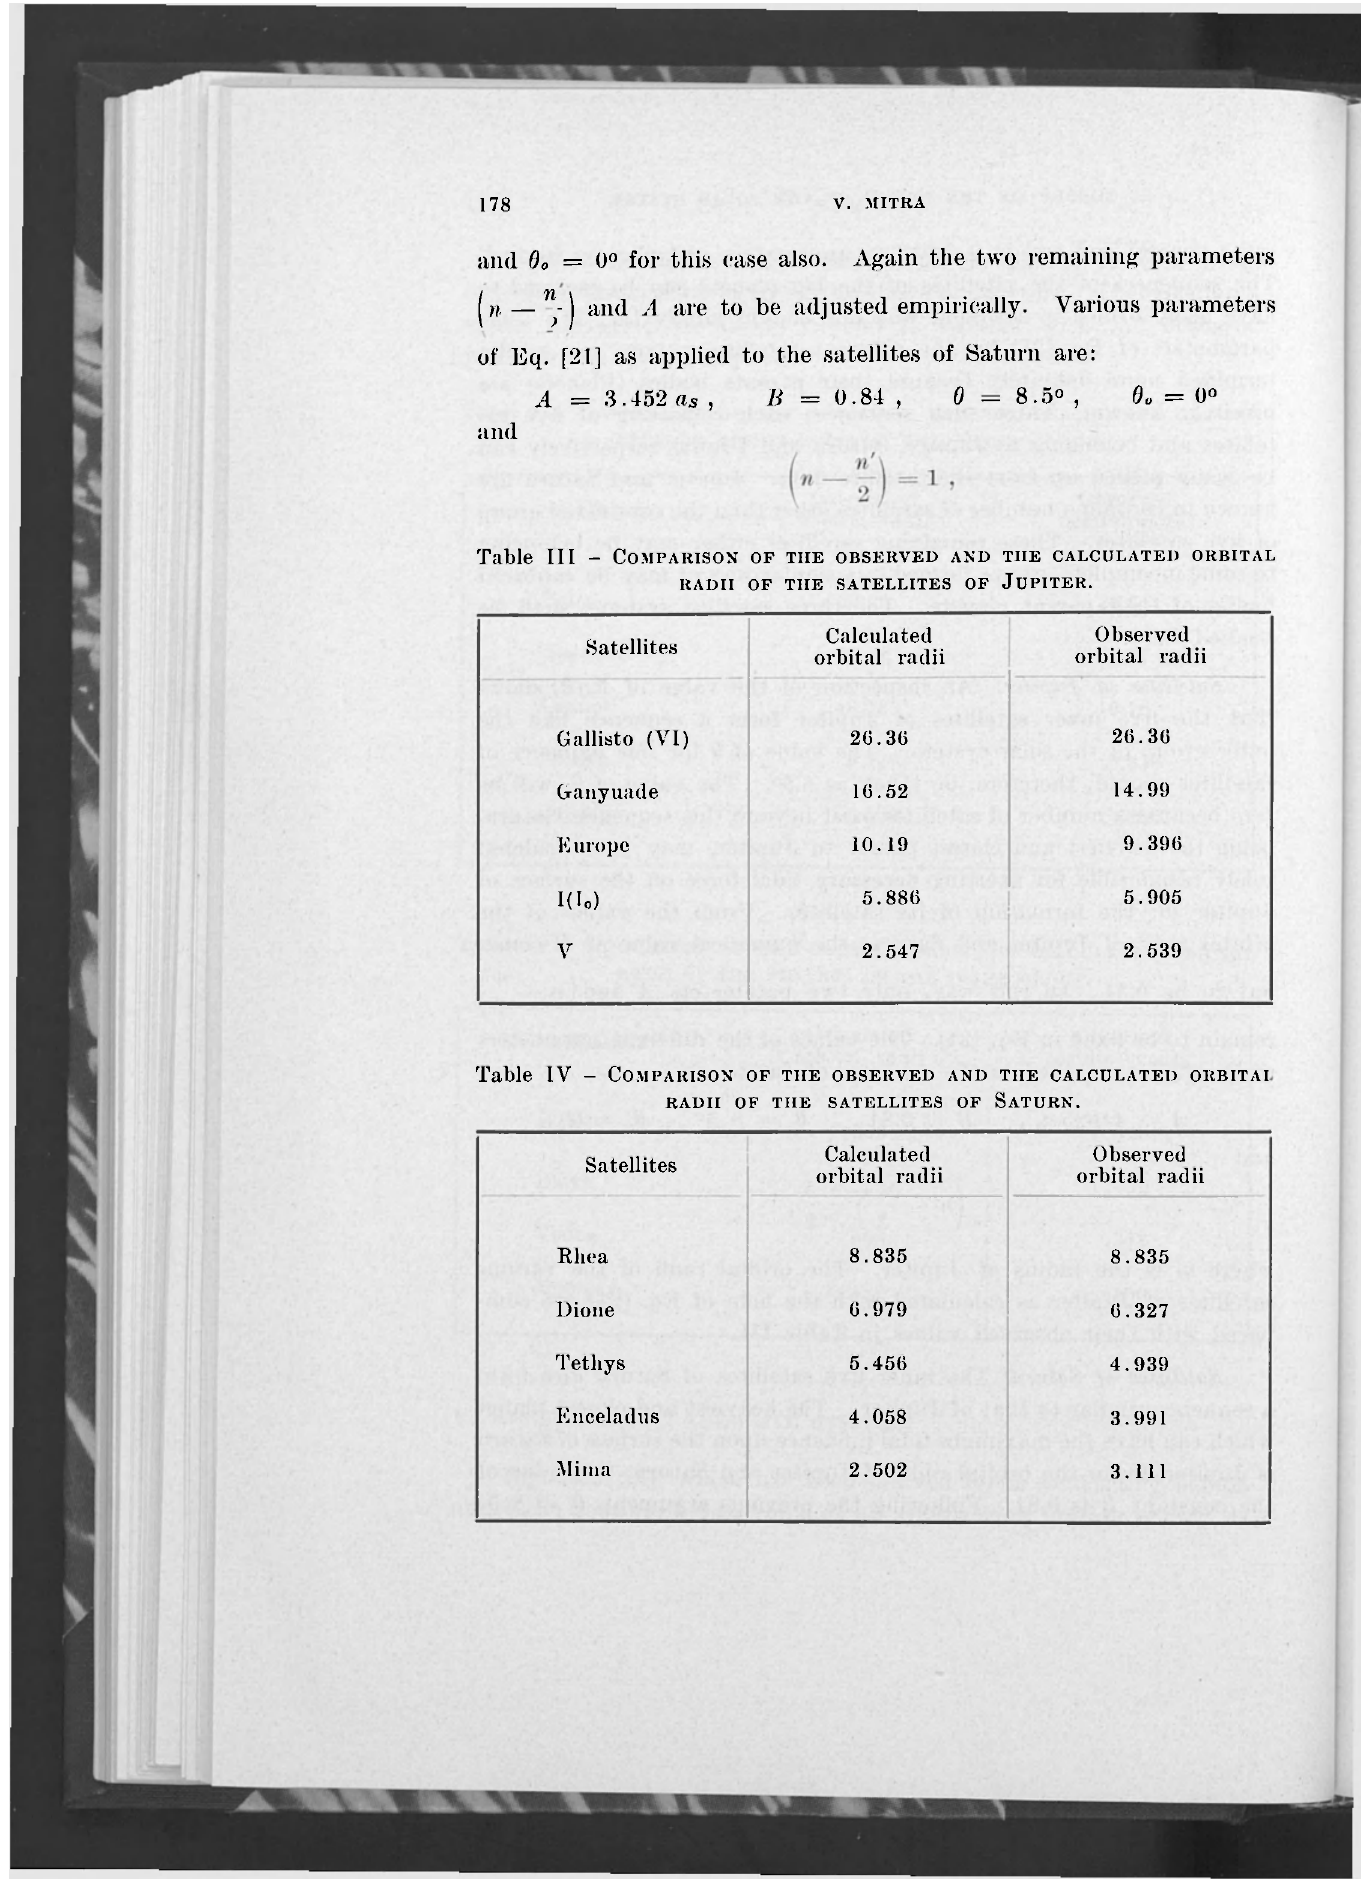
Table I II - COMPARISON OF THE OBSERVED AND THE CALCULATED ORBITAL RADII OF THE SATELLITES OF JUPITER.